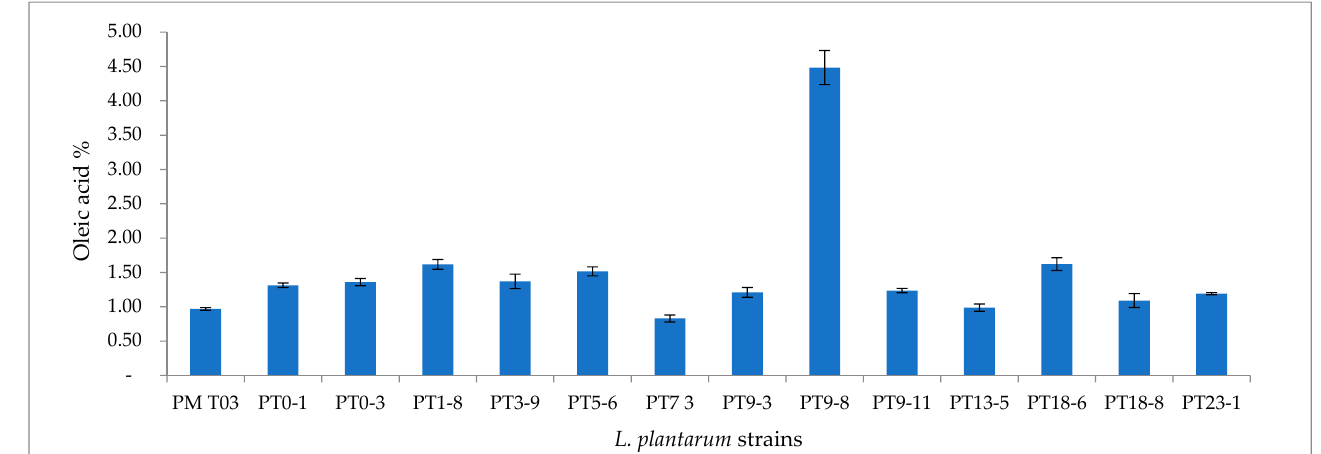
Figure 2. Lipolytic activity (% of oleic acid) of L. plantarum strains on pork fat evaluated by titration method.